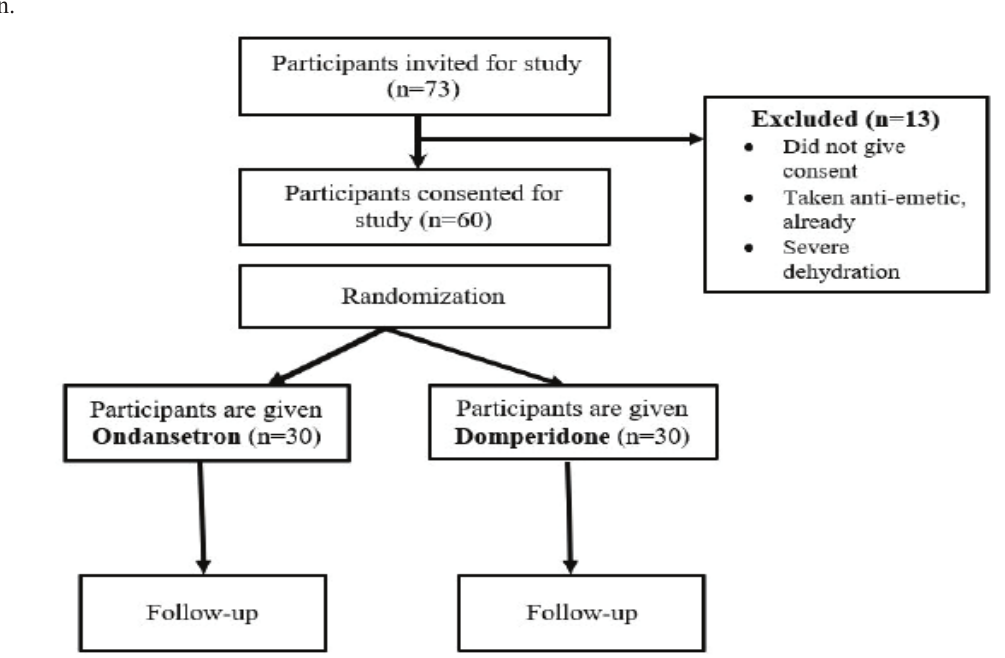
Figure-I: Flow diagram showing recruitment, assignment and follow-up of participants in the